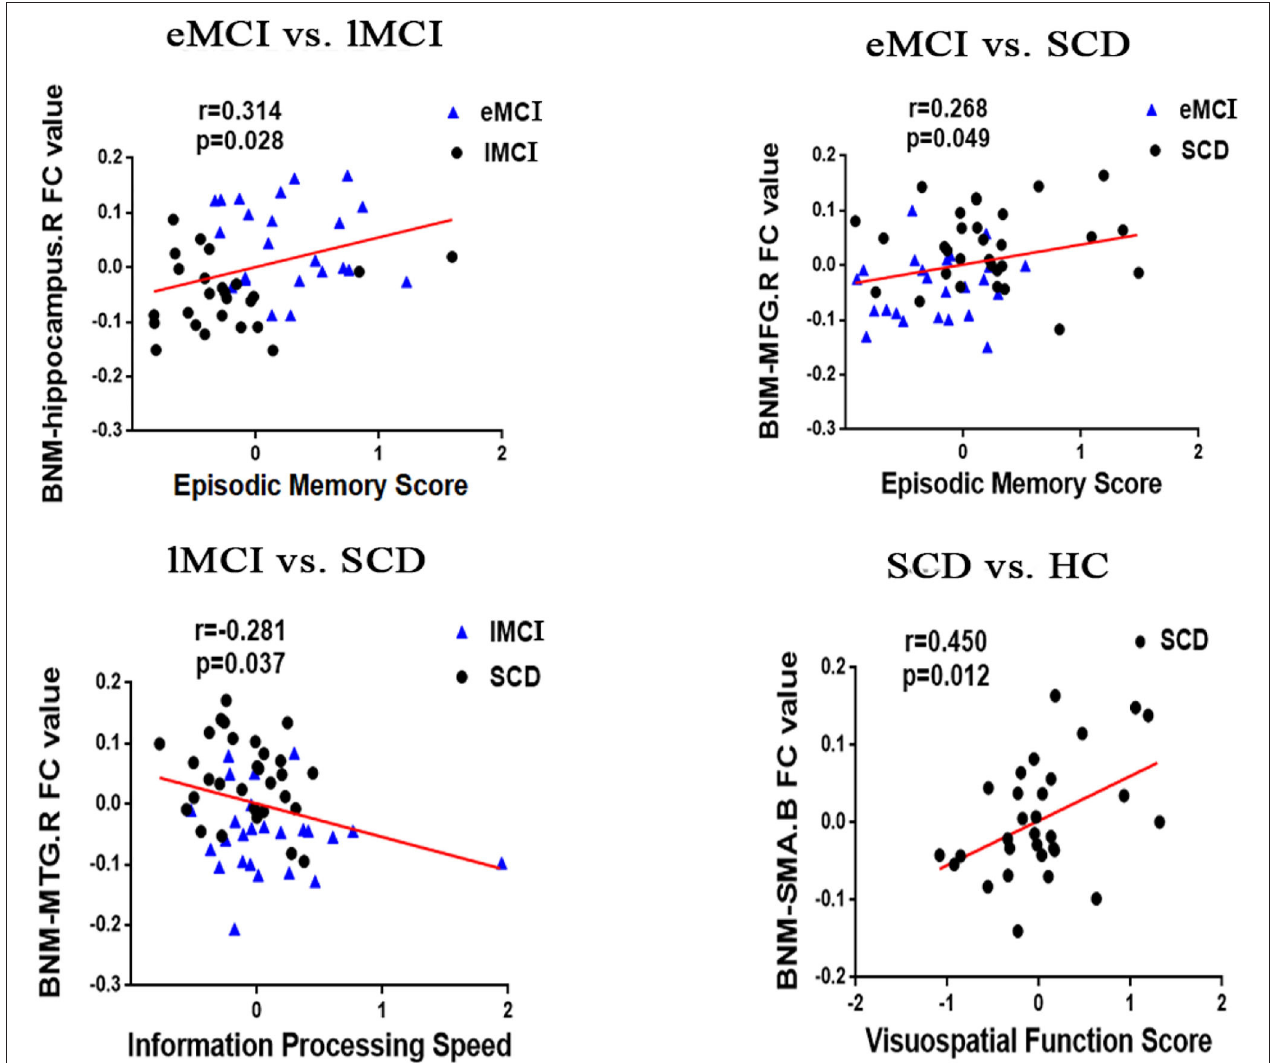
FIGURE 2 | Significant associations between altered BNM-FC and cognitive function including episodic memory, executive function, and information processing speed (Bonferroni corrected, p < 0.05). Age, gender, and years of education were used as covariates for all these results. eMCI, early mild cognitive impairment; lMCI, late mild cognitive impairment; SCD, subjective cognitive decline; HC, healthy controls; SMA, supplementary motor area; SFG, superior frontal gyrus; MFG, middle frontal gyrus; L, left hemisphere; R, right hemisphere; B, bilateral